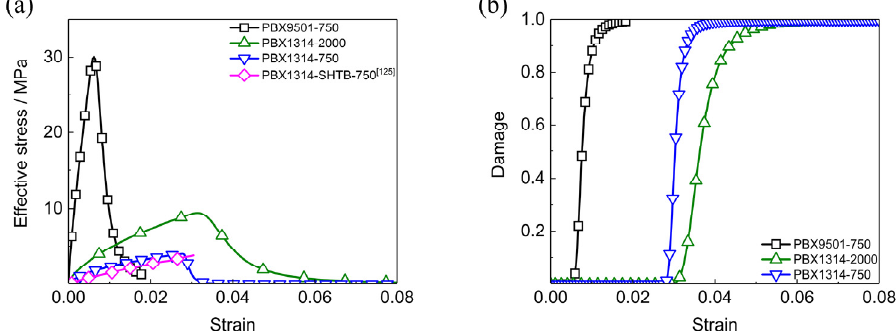
Figure 4. Dynamic mechanical responses of PBX1314 and PBX9501 under uniaxial tensions. ( a ) Stress– strain curves, ( b ) damage–strain curves.